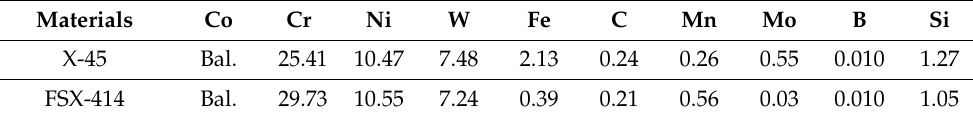
Table 1. Chemical compositions of cobalt-based superalloys X-45 and FSX-414 (wt.%). Materials